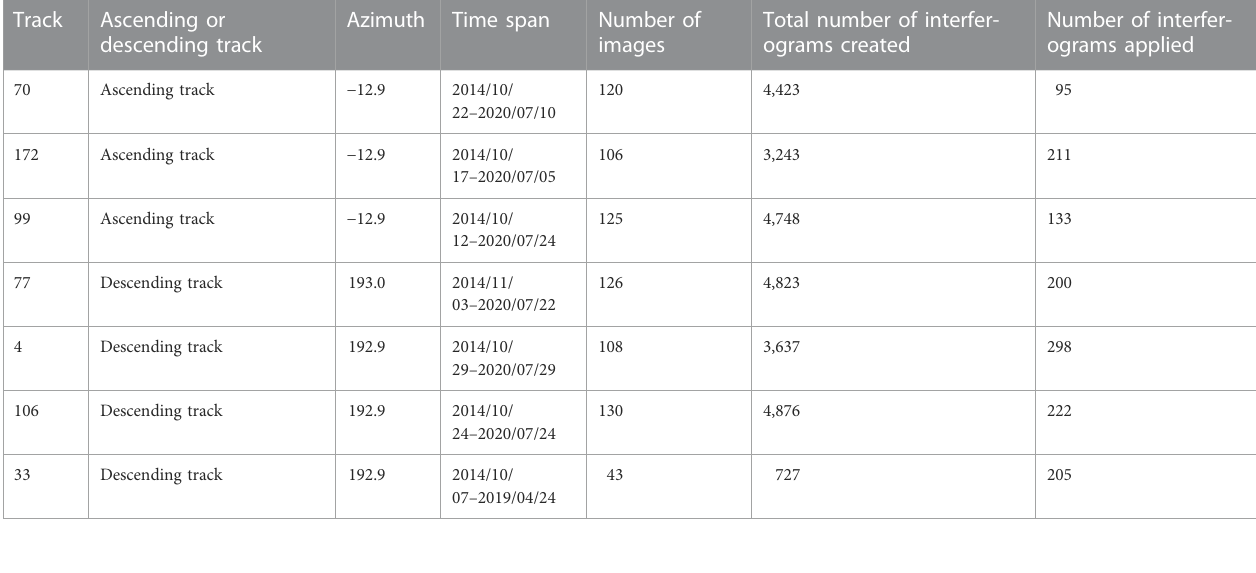
TABLE 1 Information on Sentinel-1 data used in this study.